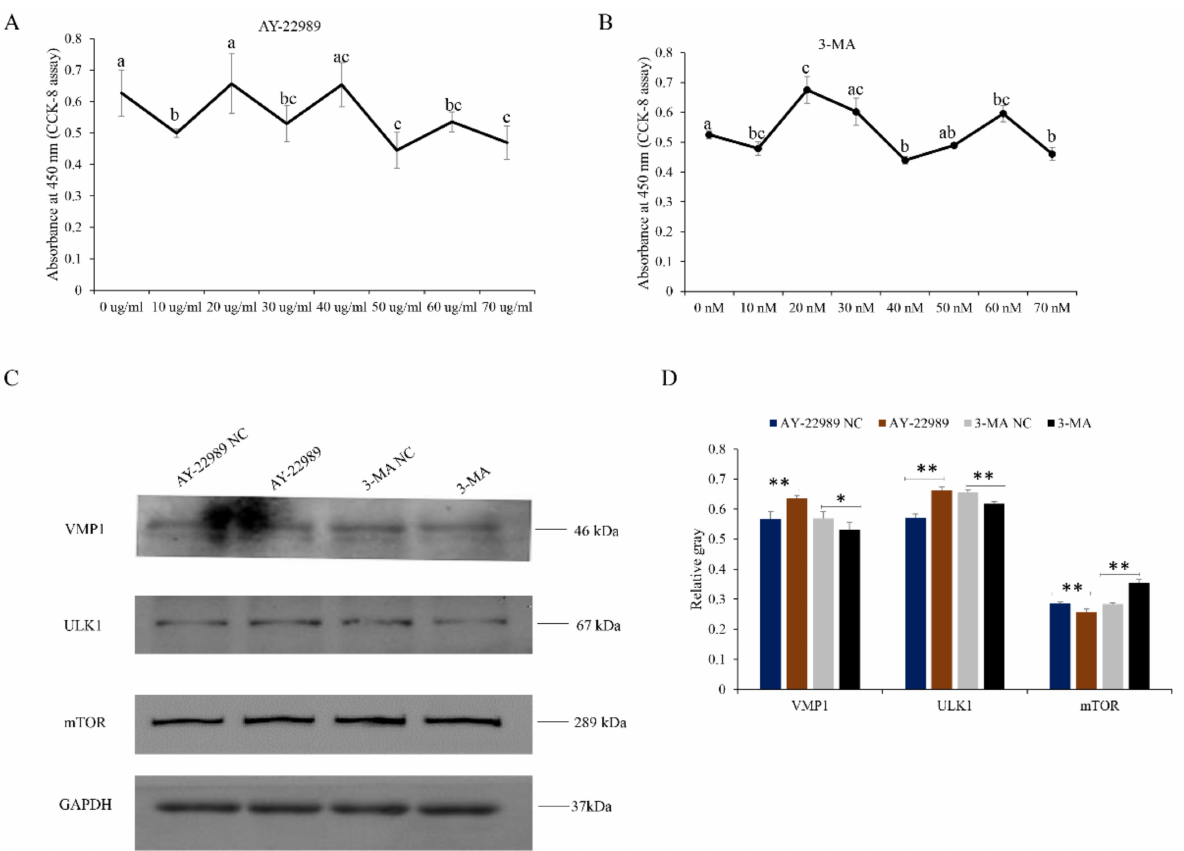
Figure 8. Phosphoinositide 3-kinase (PI3K/AKT/mTOR) pathway analysis: ( A , B ) CCK-8 assays were used to determine the optimal concentrations of the mTOR activator (AY-22989) and inhibitor (3-MA). ( C , D ) Levels of mTOR and downstream regulators (VMP1 and ULK1) in myoblasts were detected by Western blotting after treatment with AY-22989 or 3-MA. GAPDH was used as an internal control. Replicates = 3. Data are presented as the mean ± SE; * p < 0.05 and ** p < 0.01. The different letters represented the significant